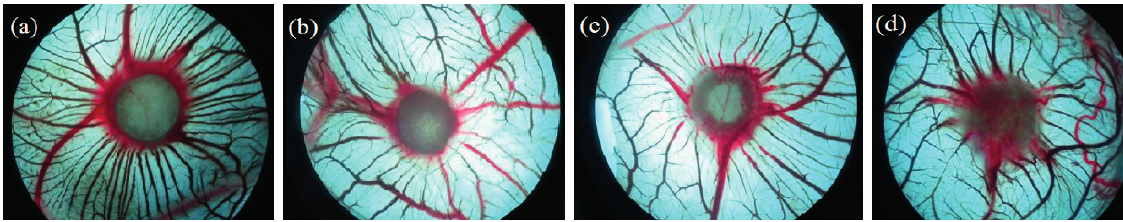
Figure 2. Microvascular proliferation of S-CA on CAM (×50). ( a ) Blank control for S-CA group, ( b ) Positive control for S-CA group, ( c ) 10 μ g/egg for S-CA group, ( d ) 40 μ g/egg for S-CA group. Table 2. Effect of S-CA on angiogenesis inhabitation (